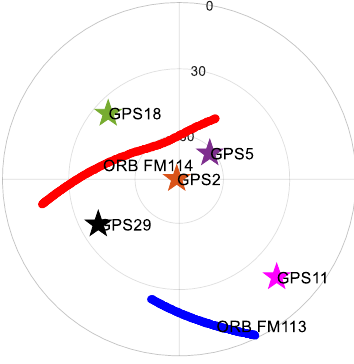
Figure 10. Sky plot of GPS and ORBCOMM.